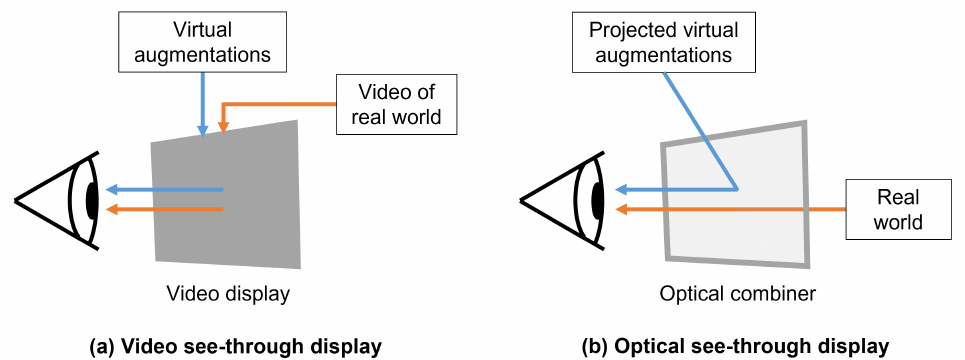
Figure 2. A simplified image representation of video see-through ( a ) and optical see-through ( b ) head- mounted displays (HMDs). Video see-through HMDs use an opaque video display to present virtual content combined with video of the real world. Real world video is typically captured by front- facing red-green-blue cameras on the front of the HMD. Optical see-through HMDs make use of a transparent optical combiner to merge virtual content, projected into the field of view of the wearer, with a view of the real